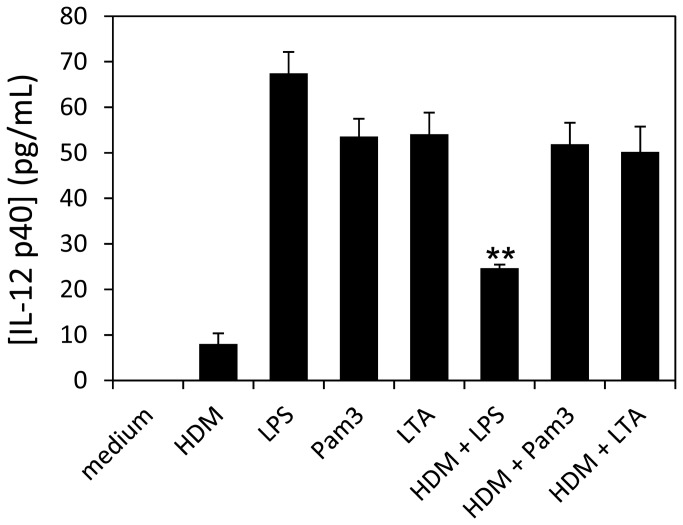
HDM extract induces low production of IL-12p40 and down-modulates the LPS induced of IL-12p40 secretion level in MH-S cells.MH-S cells were incubated with HDM extract or with the individual TLR2 and TLR4 agonists alone (LPS: 0.1µg/mL; Pam3: 0.01µg/mL; LTA: 1µg/mL) or in combination with HDM extract and the IL-12 concentration in supernatants was evaluated at 24h by ELISA after cell centrifugation. All samples were analyzed in triplicate and bars represent the mean ± SEM from duplicate experiments. Statistical analysis was performed using Student’s t-test; **p<0.01.